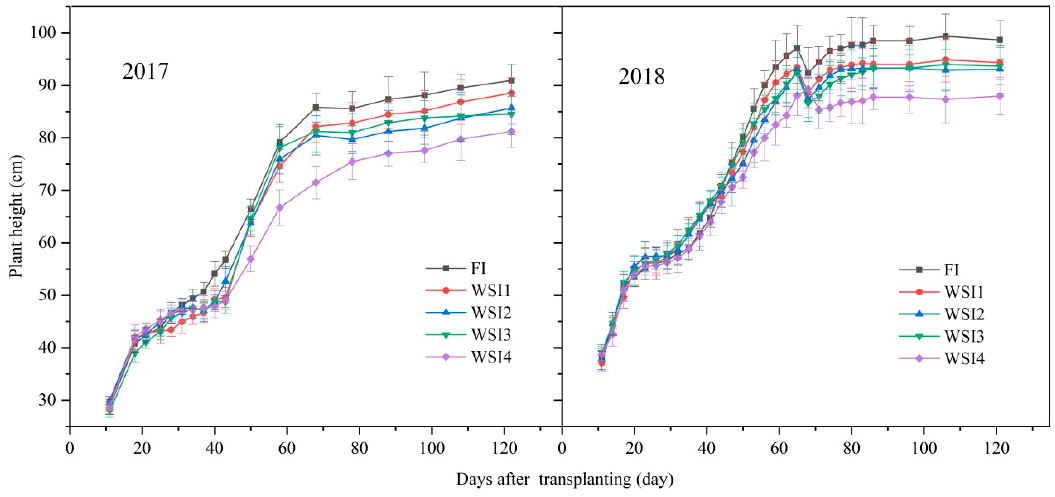
Figure 4. The variation of the rice plant height in 2017 and 2018.